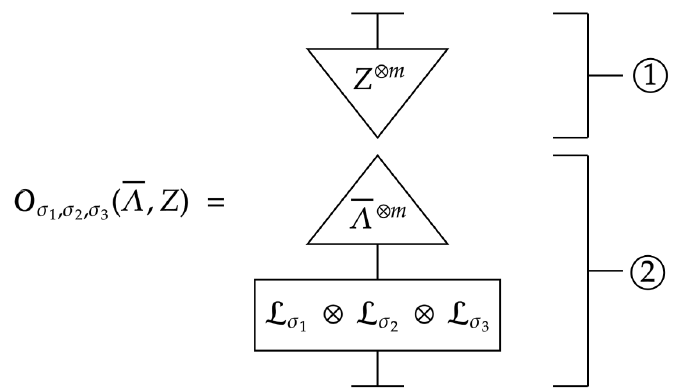
(¯Λ , Z ) , with 1 ,σ 2 ,σ 3